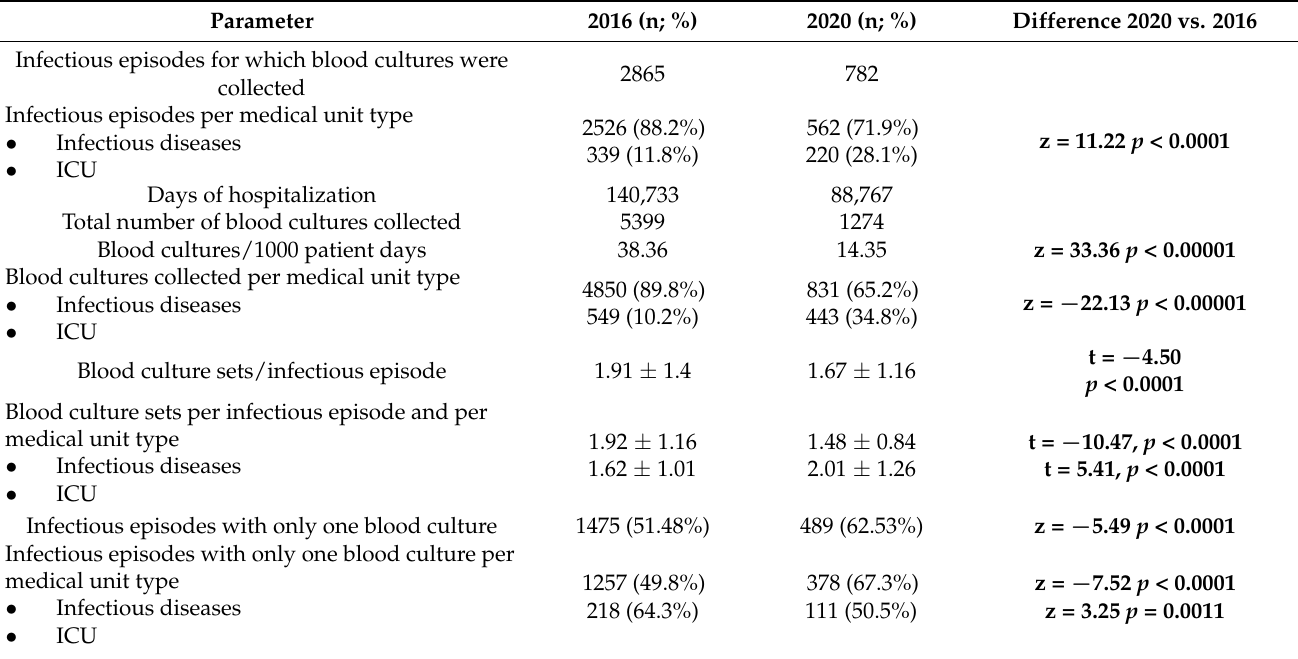
Table 2. Blood culture use in 2020 compared to 2016—hospital and medical unit type changes. Parameter